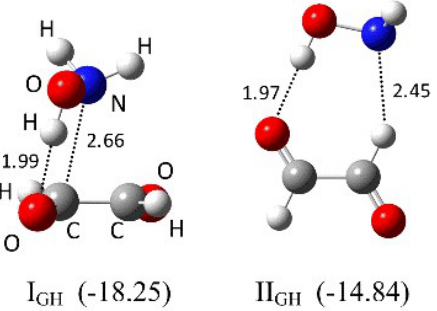
Figure 1. The MP2/6-311++G(2d,2p) optimized structures of the Gly–HA complexes identified in argon and nitrogen matrices. The ∆ E CP (ZPE) binding energies in kJ mol − 1 are given in parentheses. The intermolecular distances are given in Å.